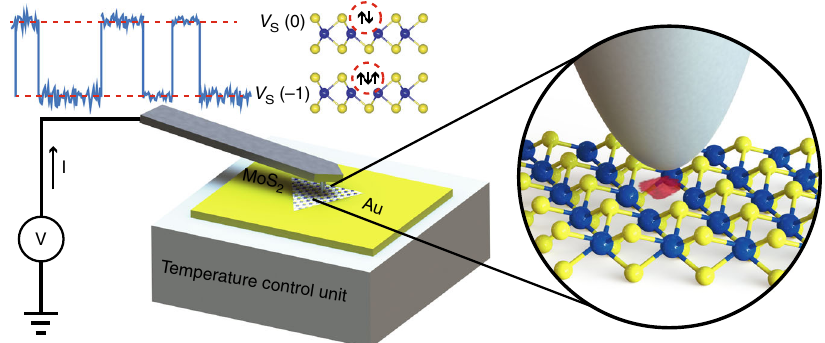
Fig. 1 Schematic illustration of LF noise measurement system. MoS 2 fl akes transferred to a conducting gold-coated substrate are probed by conductive AFM. The current fl owing through the sample, I = I bias + I ac , is composed of the bias current I bias that is constant due to the 100 M Ω series resistor, and the noise signal I